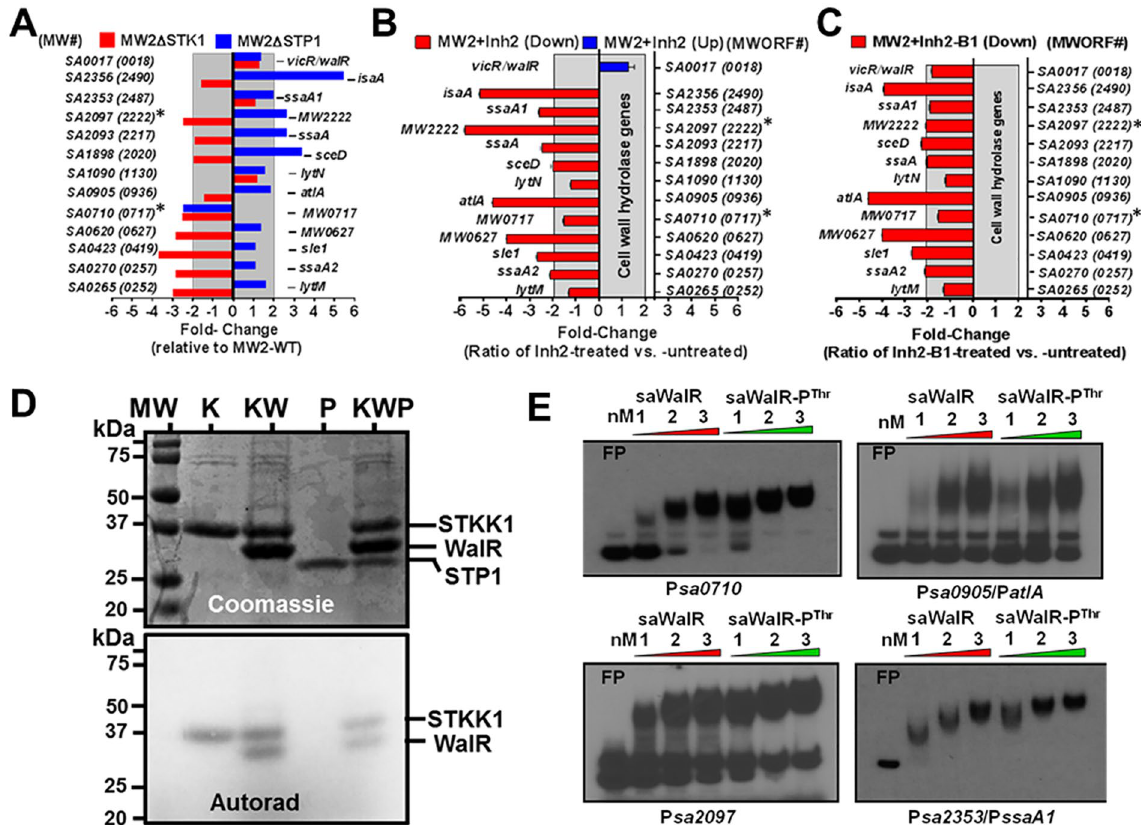
Figure 5. Inh-2 and Inh2-B1 treatment adversely affect the expression of genes encoding cell wall hydrolases in S . aureus via inhibiting STK1 activity. ( A ) qRT-PCR-based mRNA expression profiles of cell wall hydrolase genes in MW2 Δ STK1 and MW2 Δ STP1 mutants vs. MW2-WT show the reciprocal regulation in the absence of STK1 and STP1. Numbers shown on the Y-axis refer to ORF (open reading frame) numbers of the cell wall hydrolase-specific genes present in the S . aureus N315 genome and numbers within parentheses refer to the corresponding genes present in the MW2 genome. qRT-PCR-based mRNA expression profiles of cell wall hydrolase genes in S . aureus MW2-WT wild-type strain treated with ( B ) Inh2 and ( C ) Inh2-B1. Each horizontal bar represents an average value (Mean ± S.D.) from three different experiments each with three technical replicates. ( D ) STK1 and STP1-mediated reversible phosphorylation of S . aureus WalR. Phosphorylation assays were carried out in the phosphorylation buffer containing γ 32 P-ATP as described in the Materials and Methods section. The upper panel in ( D ) represents the Coomassie-stained SDS-page gel with differentially migrated S . aureus STKK1 (K), WalR (W), and STP1 (P) proteins. Each lane represents the combination of one or more of these proteins present in the phosphorylation, dephosphorylation, and control reaction mixtures. The lower panel is a corresponding autoradiogram of the upper panel. Numbers on the left represent molecular weight markers (MW) in kDa. ( E ) EMSAs showing the impact of the binding of different concentrations of the recombinant WalR and the STKK1-phosphorylated WalR to the promoter region of four genes-specific (SA0710, SA0905, SA2097, SA2353) γ 32 P-DNA probe on their electrophoretic migration in the